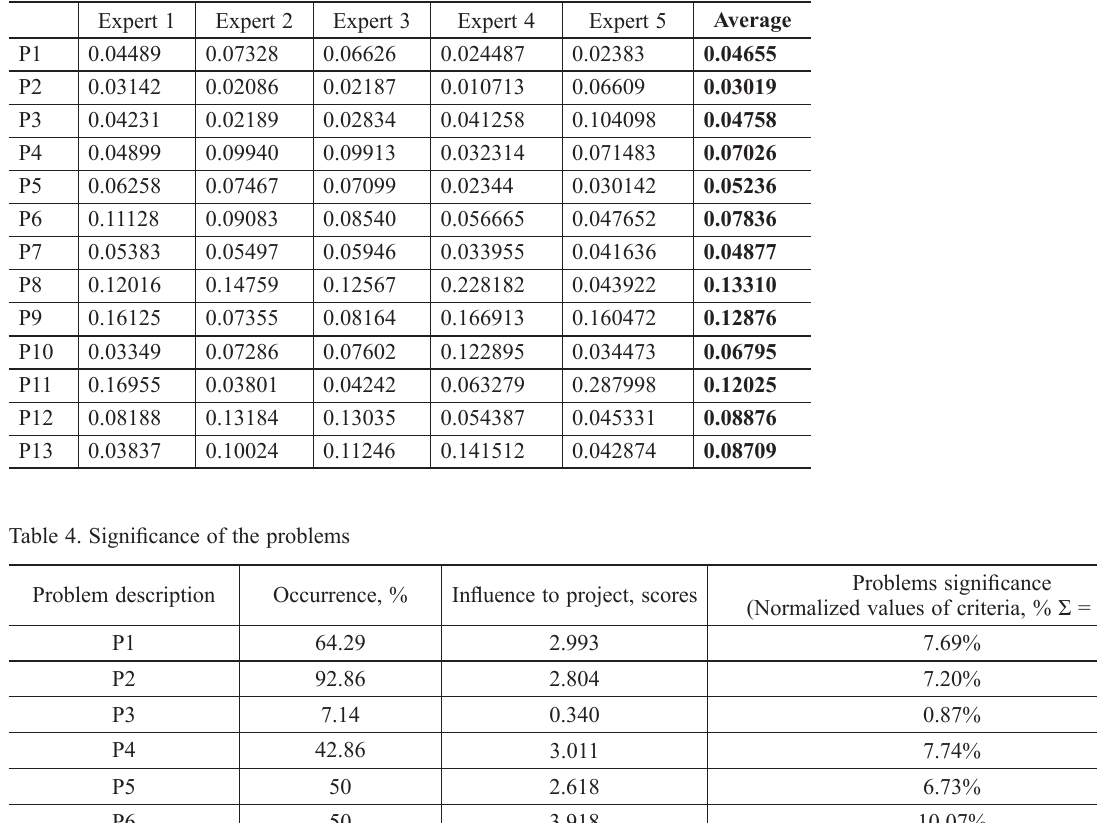
Table 3. The problem evaluation summary